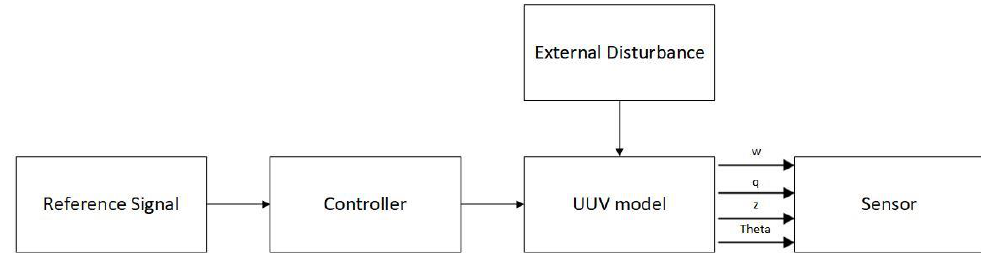
Figure 1. UUV depth control system block diagram. Table 1. The meaning of each parameter in the control system.